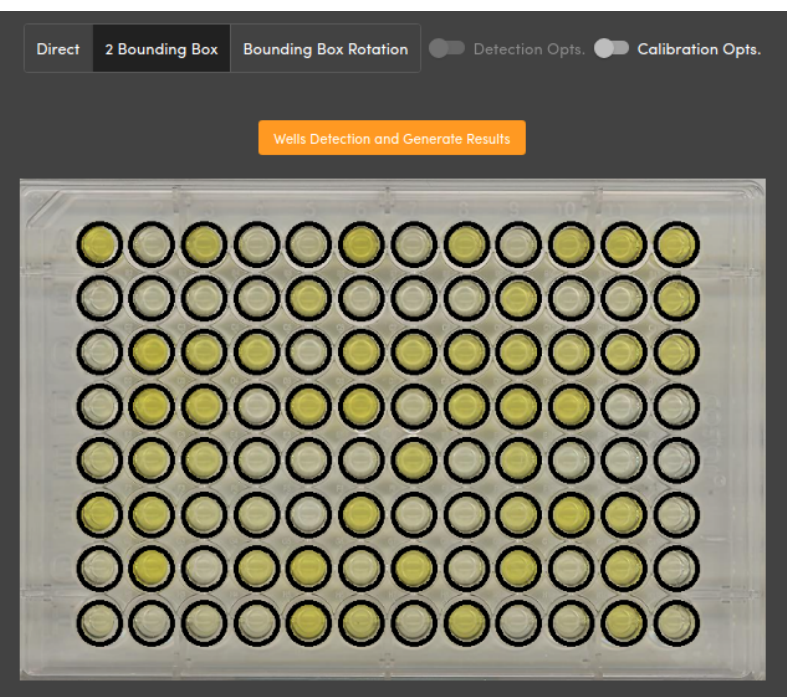
Figure 12. Detected wells using the two bounding boxes